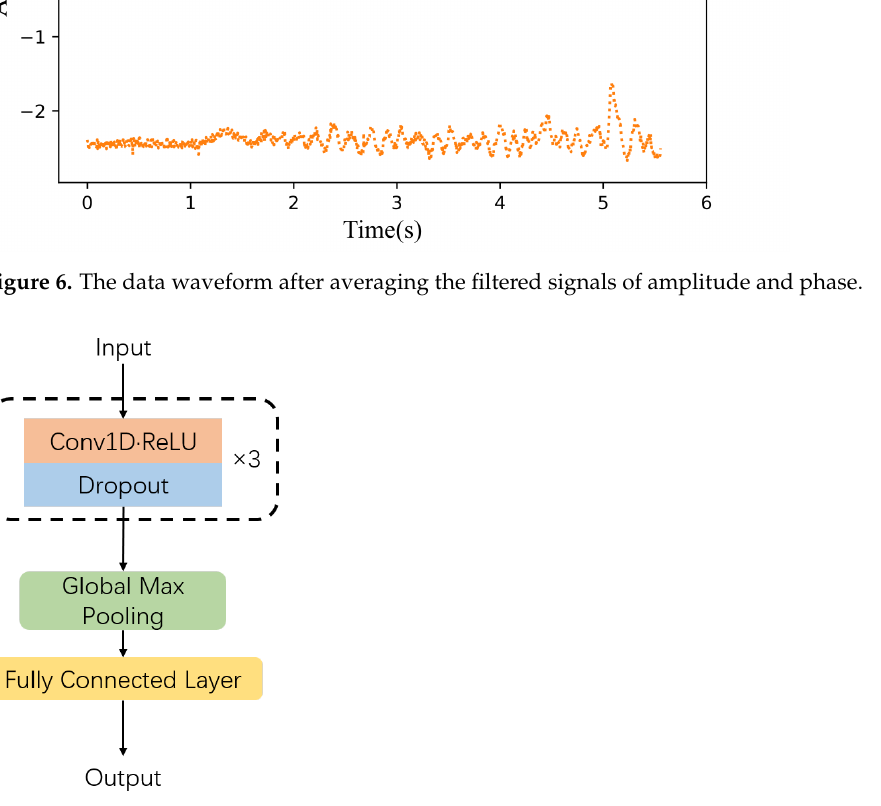
Figure 7. TPN backbone network